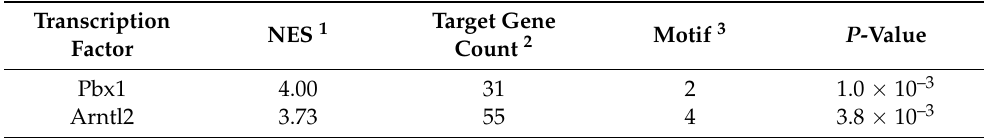
Table 7. Enriched transcription factors among target genes presenting absolute or relative splicing action modes between opioid-induced hyperalgesia and control mice in the trigeminal ganglia.